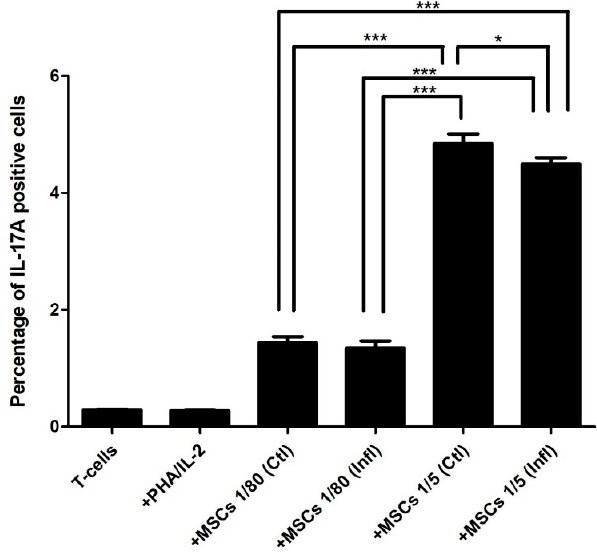
Figure 3. Influence of FSK-MSCs on IL-17A. FSK-MSCs were cocultured at a (1:5) or (1:80) cell ratio under normal and inflammatory conditions with either unactivated or PHA/IL-2-activated T cells as indicated. Levels of IL-17A expression were analyzed by flow cytometry. Data are expressed as the percentage of IL-17A ± SEM-positive cells from seven independent experiments. * p < 0.05, *** p < 0.01 versus control.